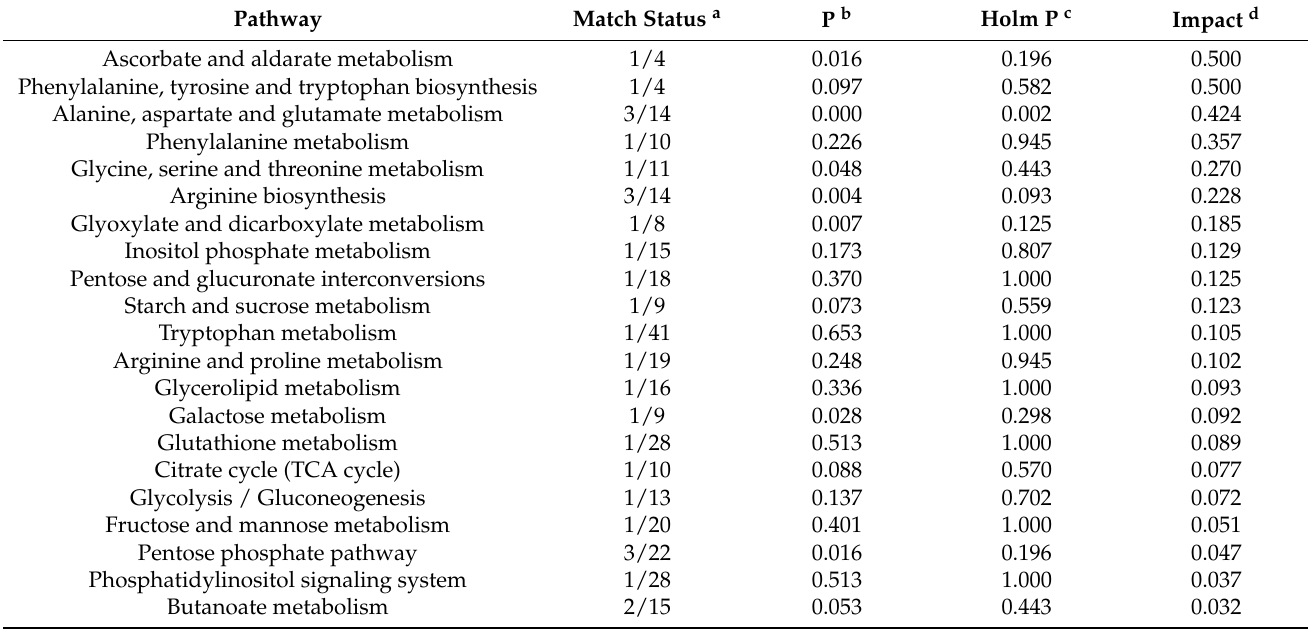
Figure 4. Differential metabolic pathways in rice seedlings related to plant resistance against pathogens. Color panels display fold changes of differential metabolites in rice seedlings treated with probenazole at 75 g · m − 2 (B group), 112.5 g · m − 2 (C group), and 150 g · m − 2 (D group) compared to non-treated group (A group), respectively. Metabolites in bold font mean a significant ( p < 0.05) differential compared to non-treated group, and metabolites in grey mean non-significant differential. Table 1. Differential metabolite of rice seedlings treated with probenazole, showing pathways containing more than two